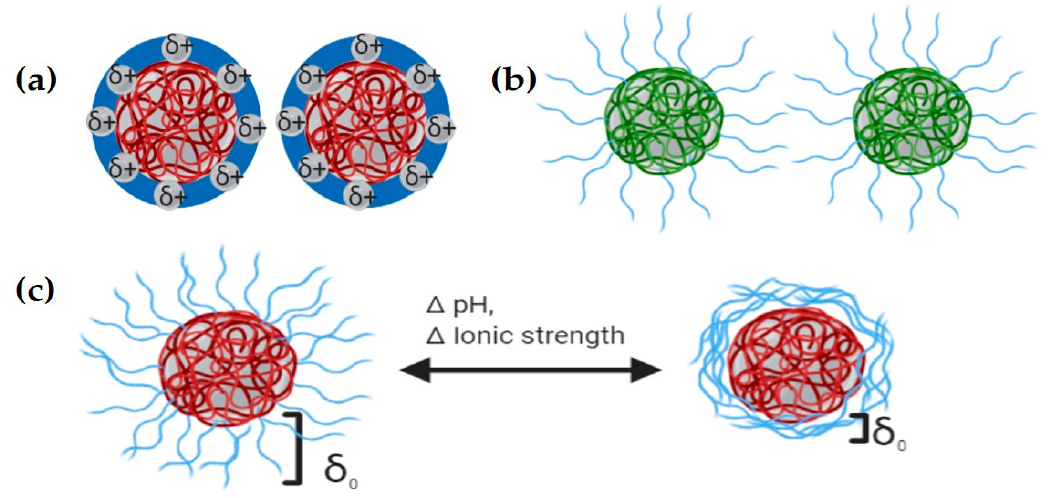
Figure 2. Mechanisms for colloidal stabilization of nanoparticles. ( a ) Electrostatic stabilization, δ + is the electric charge generating electrostatic repulsive forces among particles. ( b ) Steric stabilization. ( c ) Electrosteric stabilization as a function of pH and ionic strength, δ 0 is the thickness of polyelectrolyte.